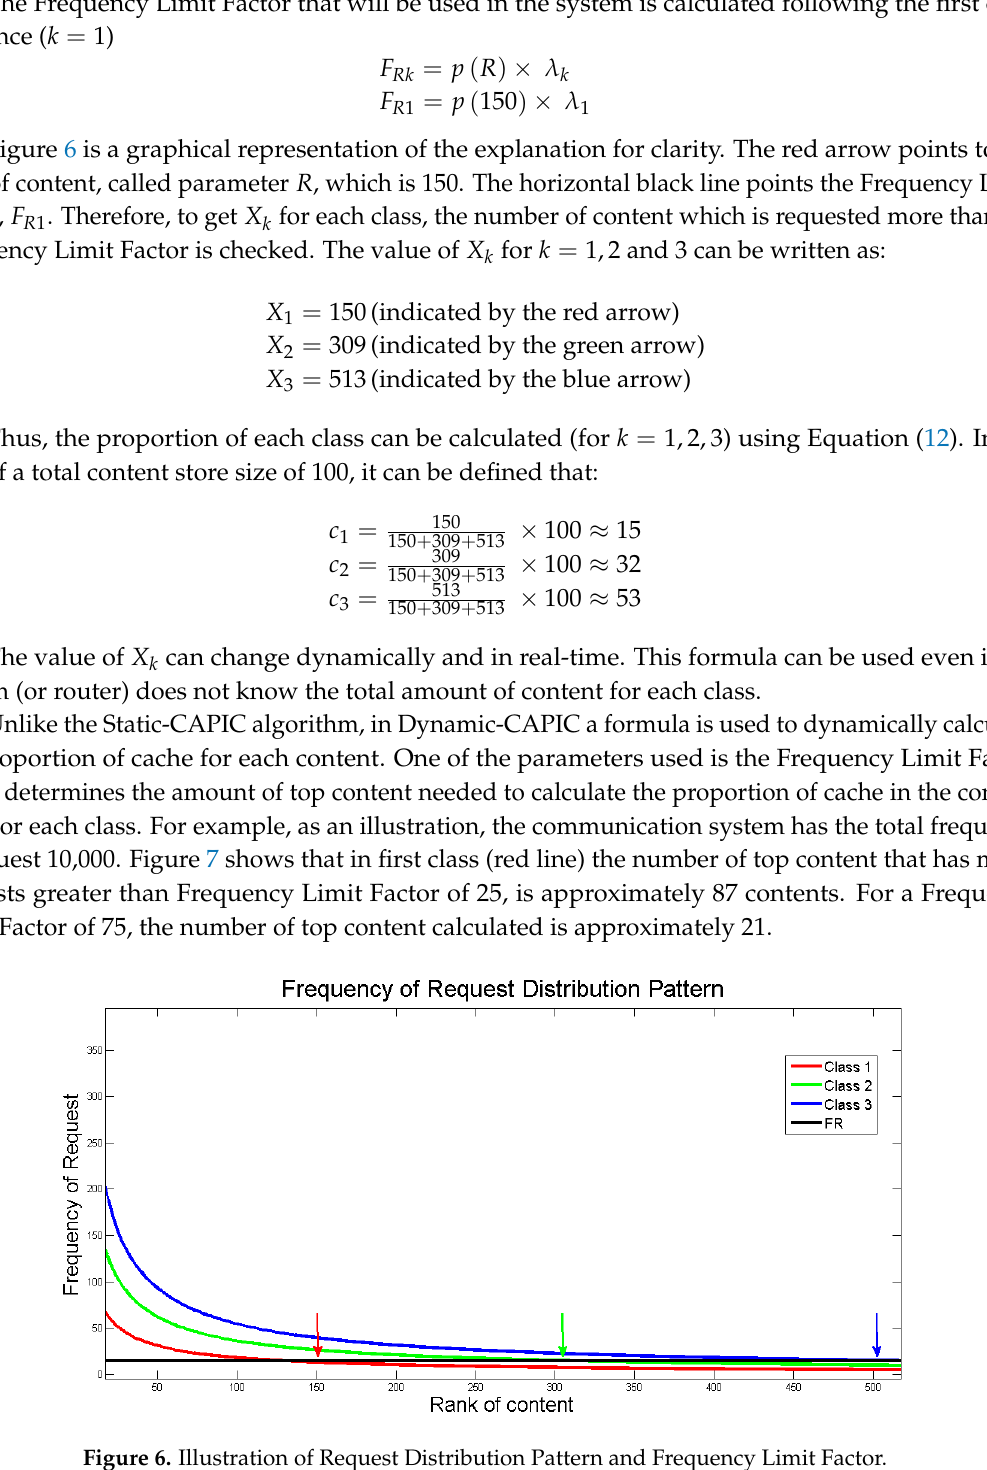
Figure 6. Illustration of Request Distribution Pattern and Frequency Limit